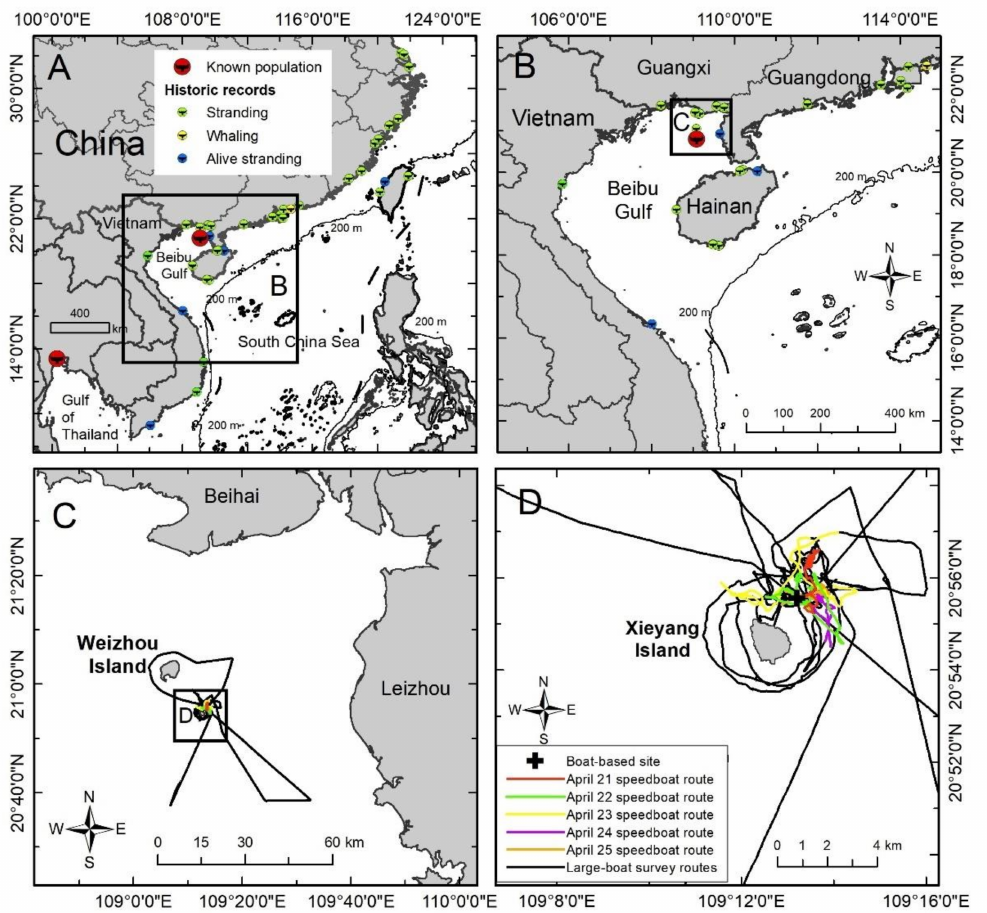
Figure 1. Map of the study area: ( A ) the South China Sea, ( B ) the northern Beibu Gulf, ( C ) the waters and boat-based survey routes around Weizhou Island, and ( D ) the waters and speedboat survey routes nearby Xieyang Island,